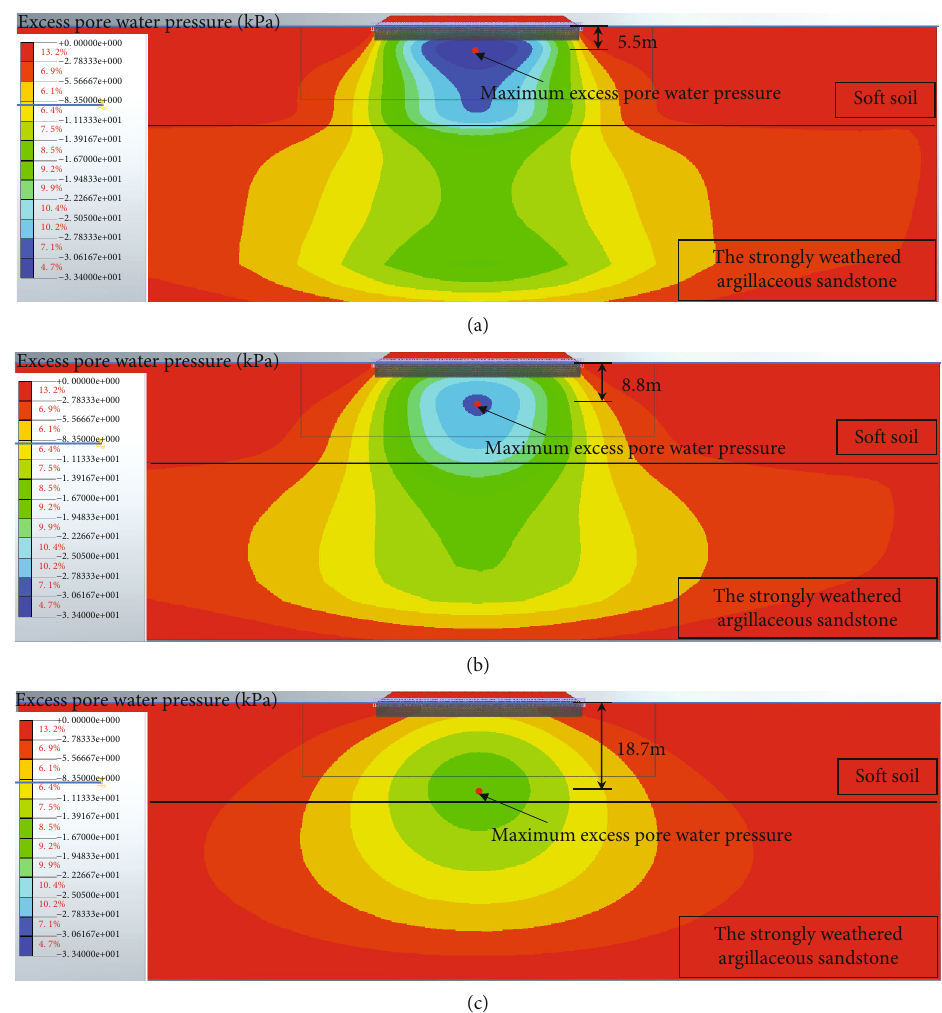
Figure 16: The colored nephogram of excess pore water pressure (a) four months, (b) seven months, and (c) twenty-nine months after road completion (the replacement thickness is 2 m).